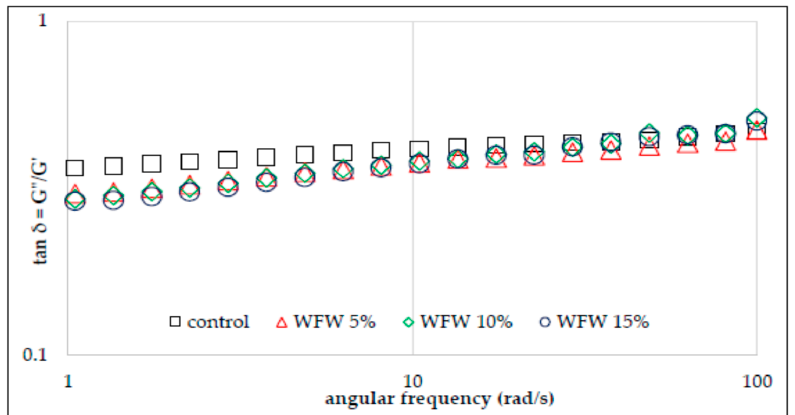
Figure 5. Tangent δ depending on the angular frequency of wheat flour gel and samples with ha- zelnuts addition.